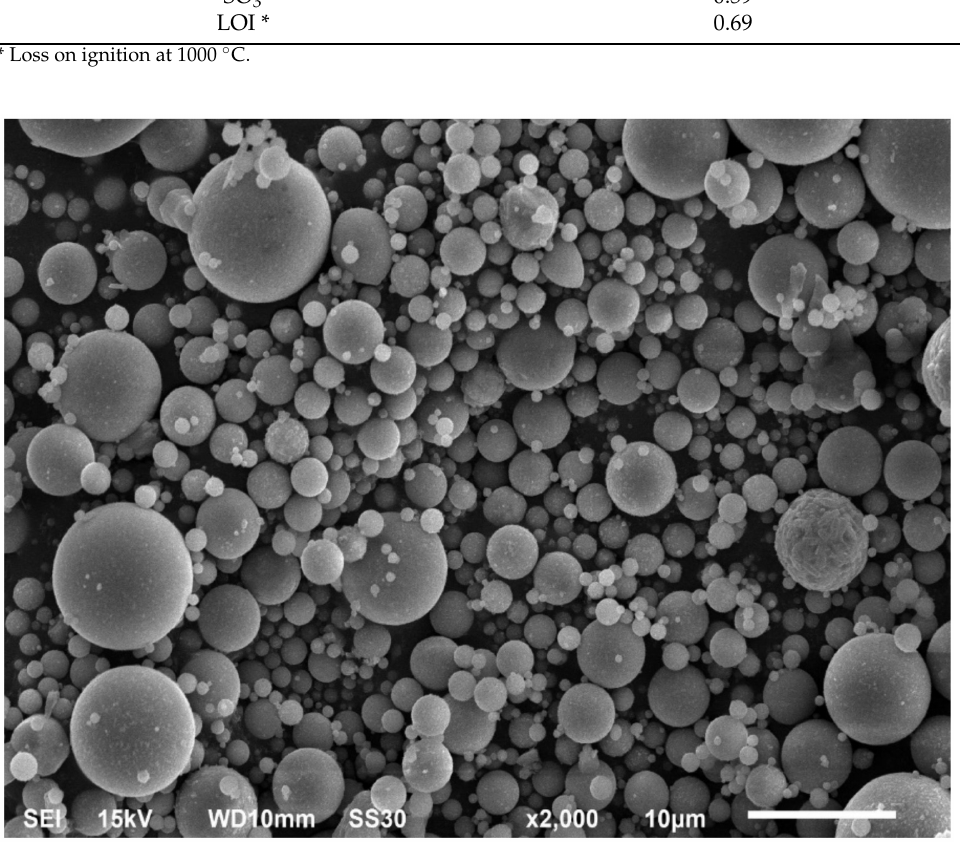
Figure 1. SEM Micrograph of